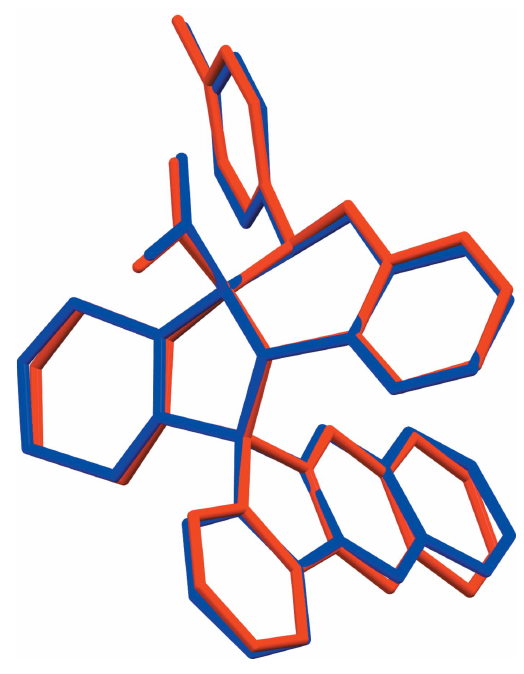
Figure 3 Aview of the molecule overlay of inverted molecule B (red) on molecule A (blue), with an r.m.s. deviation of 0.208 A˚ . The H atoms have been omitted for